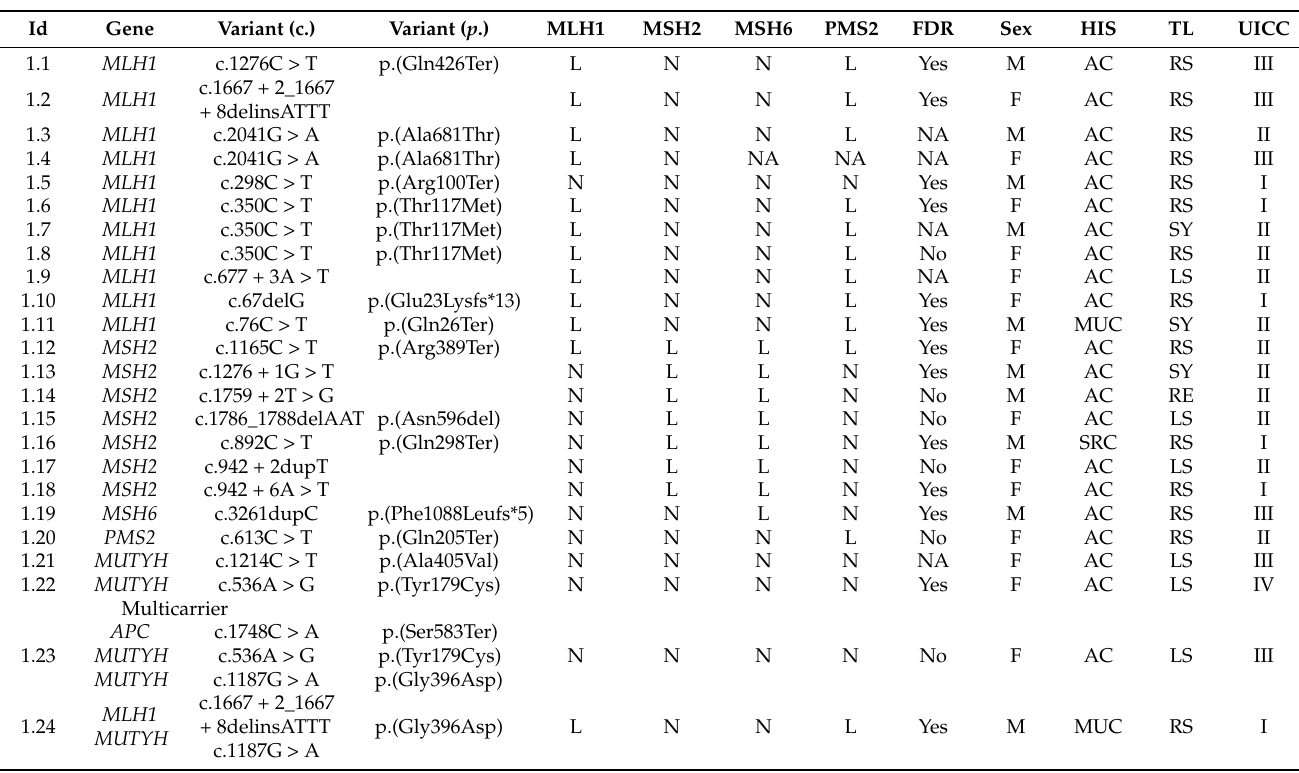
Table 1. A list of patient characteristics in 24 young colorectal cancer patients with germline pathogenic variants (PGV). All patients were heterozygous, except patient 1.23 who was compound